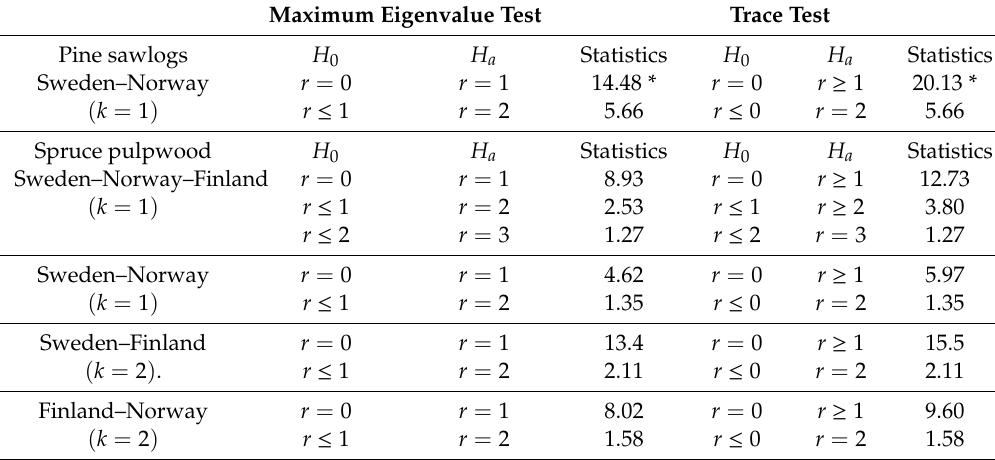
Table 2. Tests results for cointegration analysis (Johansen